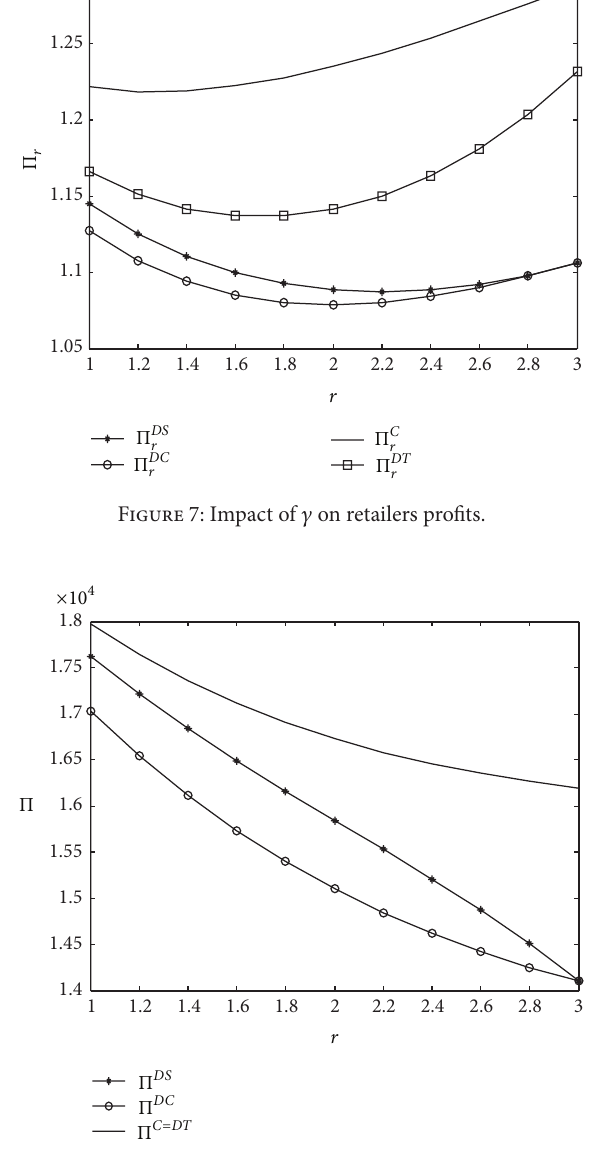
Figure 8: Impact of 𝛾 on supply chain profits.